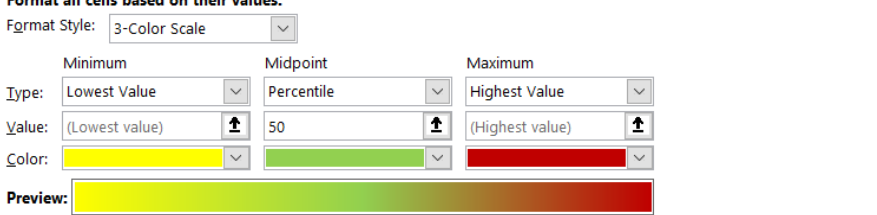
Figure 8. The graded color scale for ranking solar panels, yellow represents the best alternative, brown represents the worst alternative.